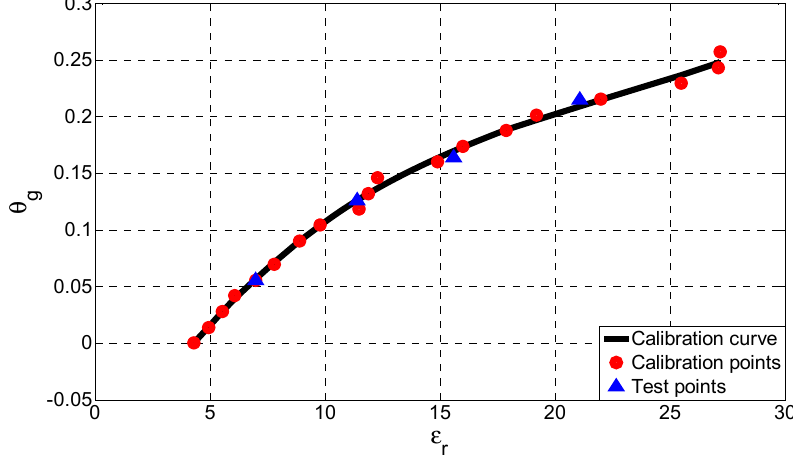
Figure 10. Calibration curve of the sensor (black line), which relates the actual permittivity of humogley soil to the gravimetric water content. The calibration curve has been created from 19 calibration points (red circles). Also shown are the results of 4 independent test measurements (blue